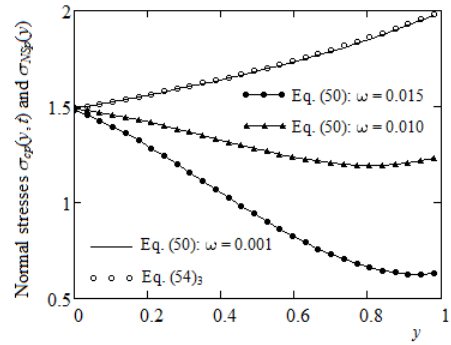
Figure 3. Convergence of long-time normal stress σ cp ( y , t ) given by Eqs. (50) to the corresponding Newtonian solution σ NSp ( y ) given by Eq. (54) 3 for α = 0.8,Re = 100,We = 1, t = 5 and ω →